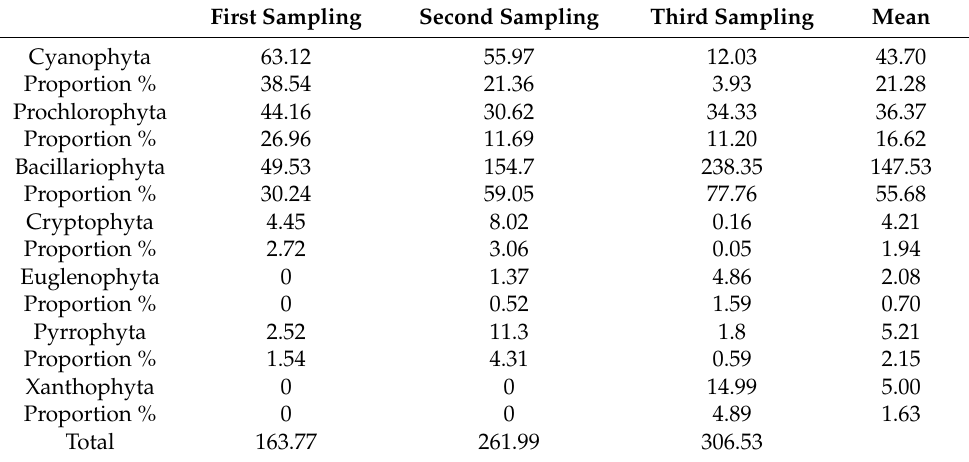
Table 8. The densities ( × 10 4 ) and proportions of phytoplankton attached to artificial